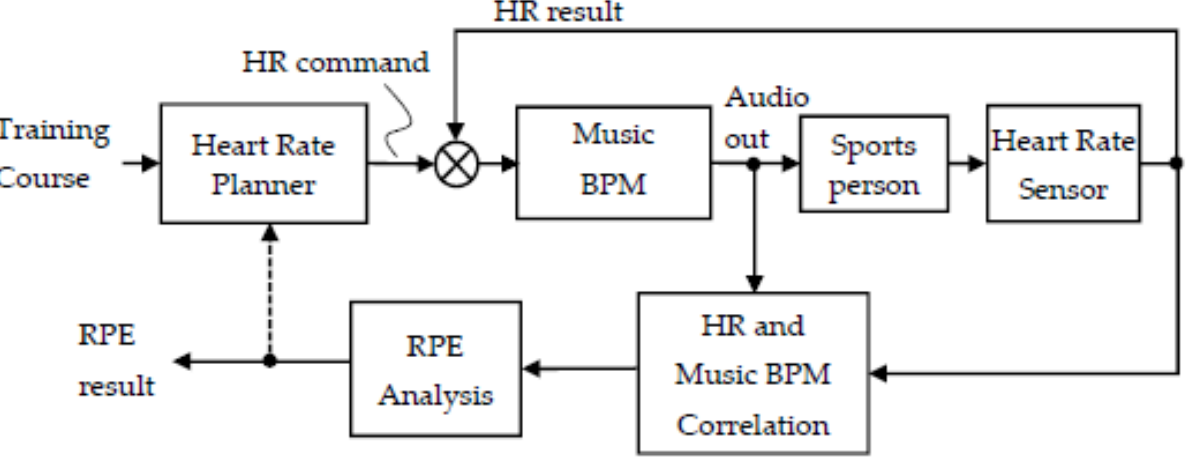
Figure 3. Correlated music tempo with heart rate (HR) in BPM.